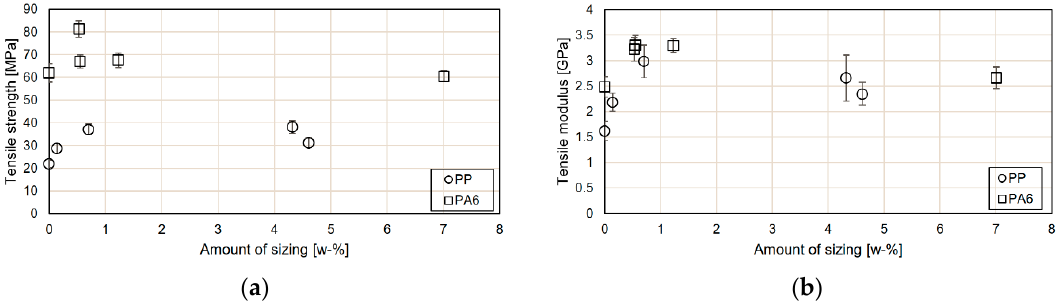
Figure 6. Tensile ( a ) strength and ( b ) modulus of the rGF composites as a function of the amount of sizing.